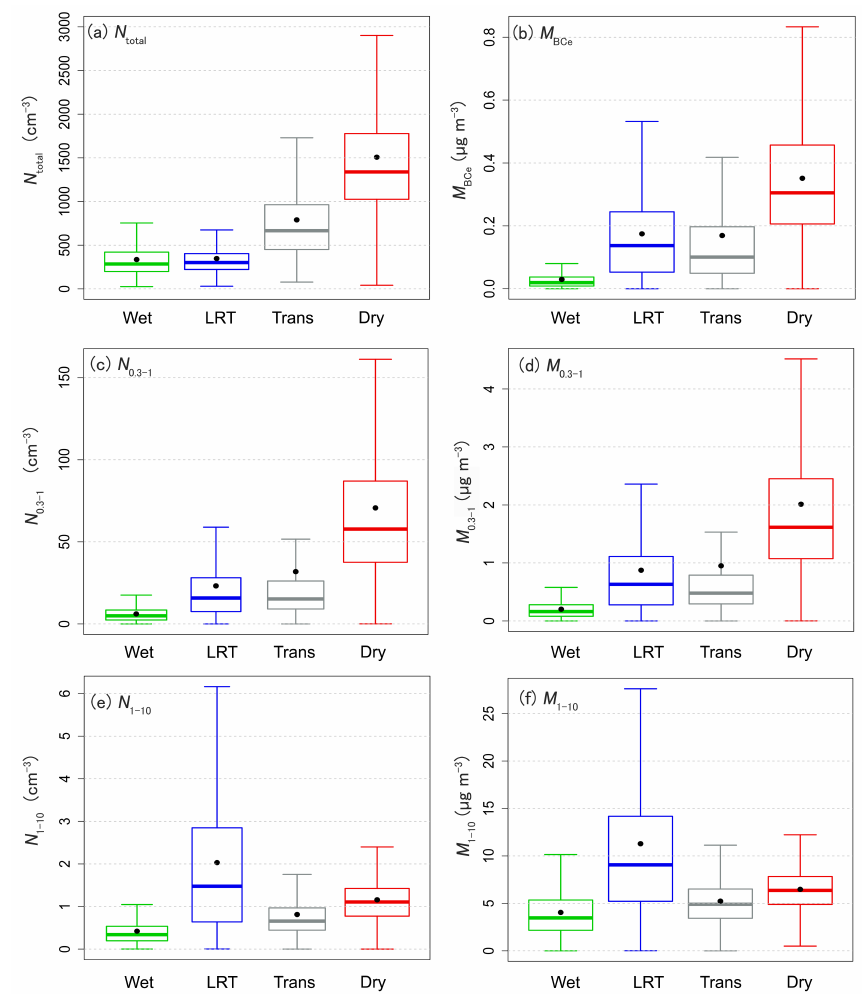
Figure 5. Statistical distributions (box-and-whisker plots) of (a) total aerosol number concentration ( > 4nm, CPC derived), (b) BC e mass concentration, M BCe , (c) aerosol number concentration in the size range 0.3–1µm, (d) aerosol mass concentration in the size range 0.3–1µm, (e) aerosol number concentration in the size range 1–10µm, and (f) aerosol mass concentration in the size range 1–10µm. Wet season, LRT episodes, transition periods, and dry season were defined according to Sect. 2.10. Data included here span from February 2014 to April 2017. The boxes show the median (thick horizontal line), mean (black dot), 25 percentile (Q1, lower border of the box), and 75 percentile (Q3, upper border). The range between Q1 and Q3 is called interquartile range: IQR = Q3–Q1. The lower whisker shows the lowest measured value still within 1.5 IQR of the lower quartile, and the highest measured value still within 1.5 IQR of the upper quartile, see Tukey